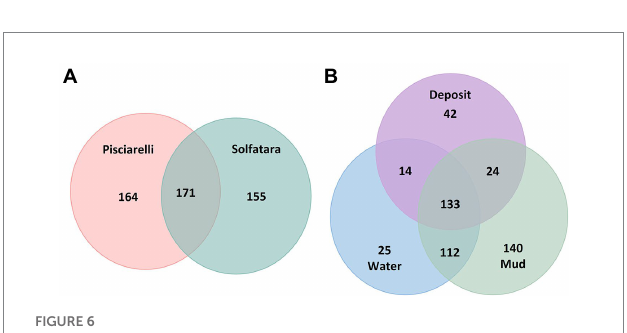
FIGURE 6 Venn diagram showing the number of unique and shared species between (A) two locations and (B) different types of substrates.